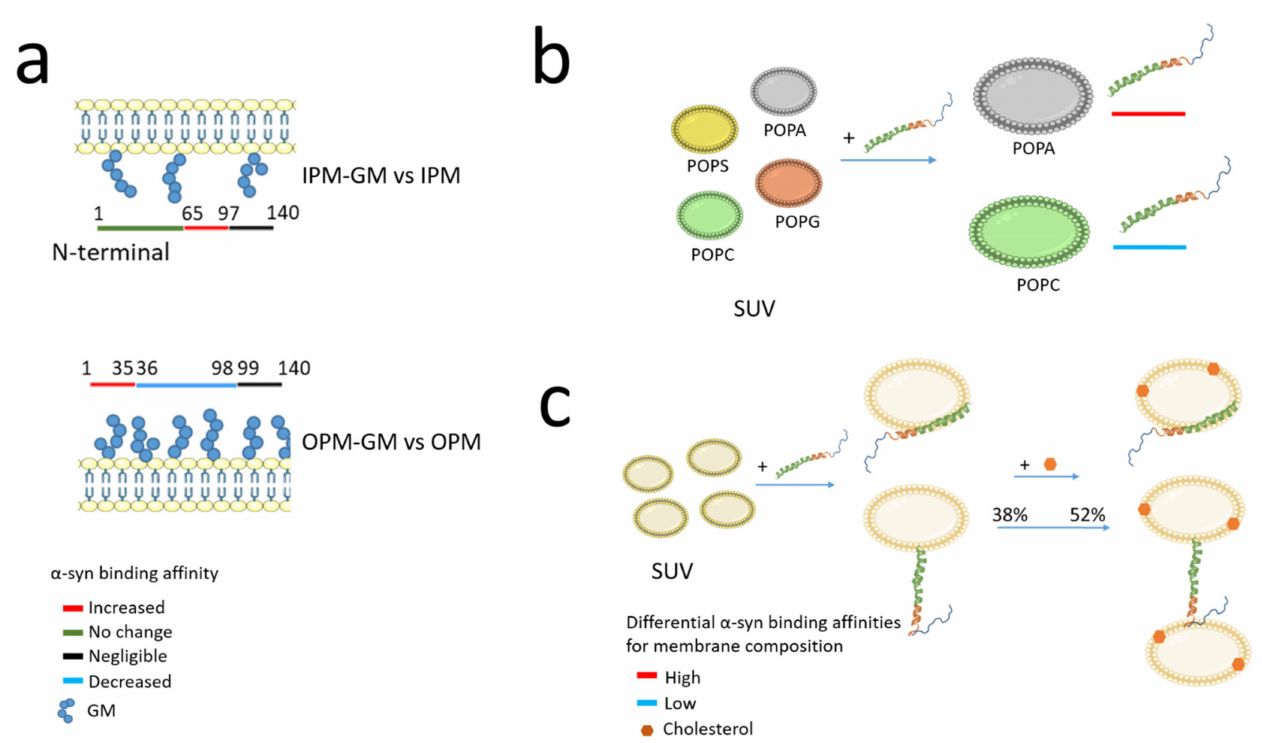
Figure 2. Schematic representation of differential affinity of α -synuclein ( α -syn) for the inner or outer plasma membrane (IPM or OPM) as well as for vesicles according to their lipid compositions. ( a ) Differential affinity of α -syn for IPM and OPM according to differences in the amount of gangliosides (GM): IPM-GM versus (vs) IPM or OPM-GM versus OPM as described by Man et al. (2021) [38]. ( b ) Differential affinity of α -syn for artificial vesicles based on their membrane composition. α -syn has a 60 times higher affinity for 1-palmitoyl-2-oleoyl- sn -glycero-3-phosphate (POPA) than 1-palmitoyl- 2-oleoyl-phosphatidyl-l-serine (POPS) and 1-palmitoyl-2-oleoyl- sn -glycero-3-phosphoglycerol (POPG) and very low affinity for 1-palmitoyl-2-oleoyl-sn-glycero-3-phosphocholine (POPC). ( c ) Effect of cholesterol on the conformation of α -syn. α -syn interacts with vesicles to promote fusion between 2 vesicles as described by Fusco et al. (2016) [61] and Man et al. (2020) [62]. Upon interaction with small unilamellar vesicles (SUV) composed of 1,2-dioleoyl-sn-glycero-3-phospho-ethanolamine (DOPE), 1,2-dioleoyl-sn-glycero-3-phospho-L-serine (DOPS), 1,2-dioleoyl-sn-glycero-3-phosphocholine (DOPC), α -syn exists in multiple different conformational states. These include the α -helical state covering the 1–97 region (top) and a con- formational state interacting with the membrane through N-terminal residues 1–25. It has been proposed by Man et al. (2020) that the presence of cholesterol in the SUV composition induces an increase in the proportion of α -syn with the conforma- tional state described at the bottom from 38% to 52%, leading to the 65–97 region being available to interact with a second SUV [62]. This suggests that cholesterol promotes the docking of the vesicles-mediated by α